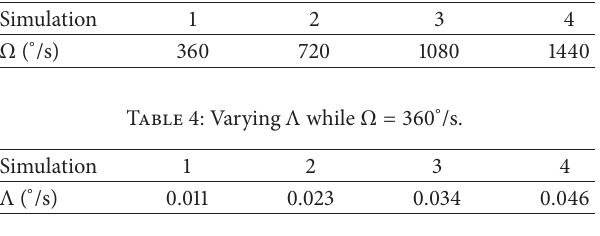
Table 3: Varying Ω while Λ = 0.011 ∘ /s.